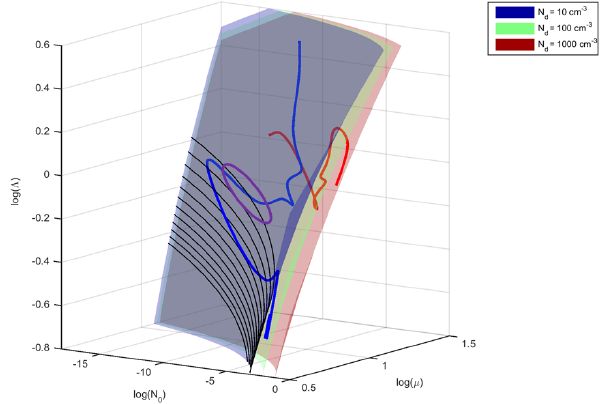
Figure 10. Surfaces of constant N d as calculated by the inversion of Eq. (6). The trajectories for the clouds measured during flights RA1 (blue) and AD2 (red) are also shown. Note that the axes are rotated for clarity. The purple ellipse represents an estimation of the size of the ellipsoids introduced by McFarquhar et al. (2015) – see text for more